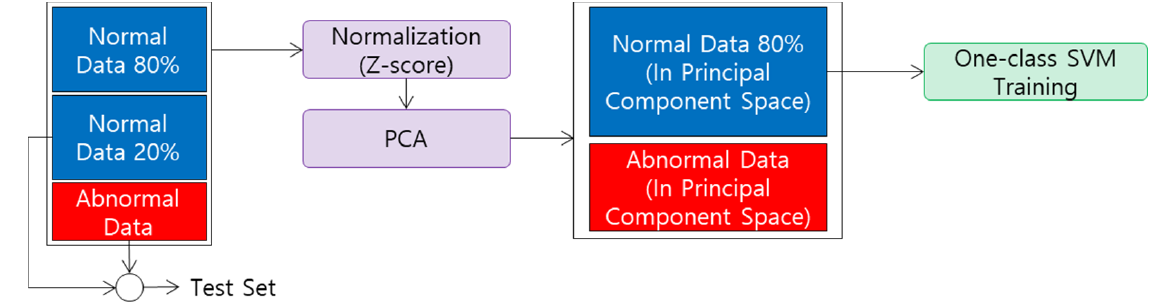
Figure 11. One-class SVM-based anomaly detection model training architecture.